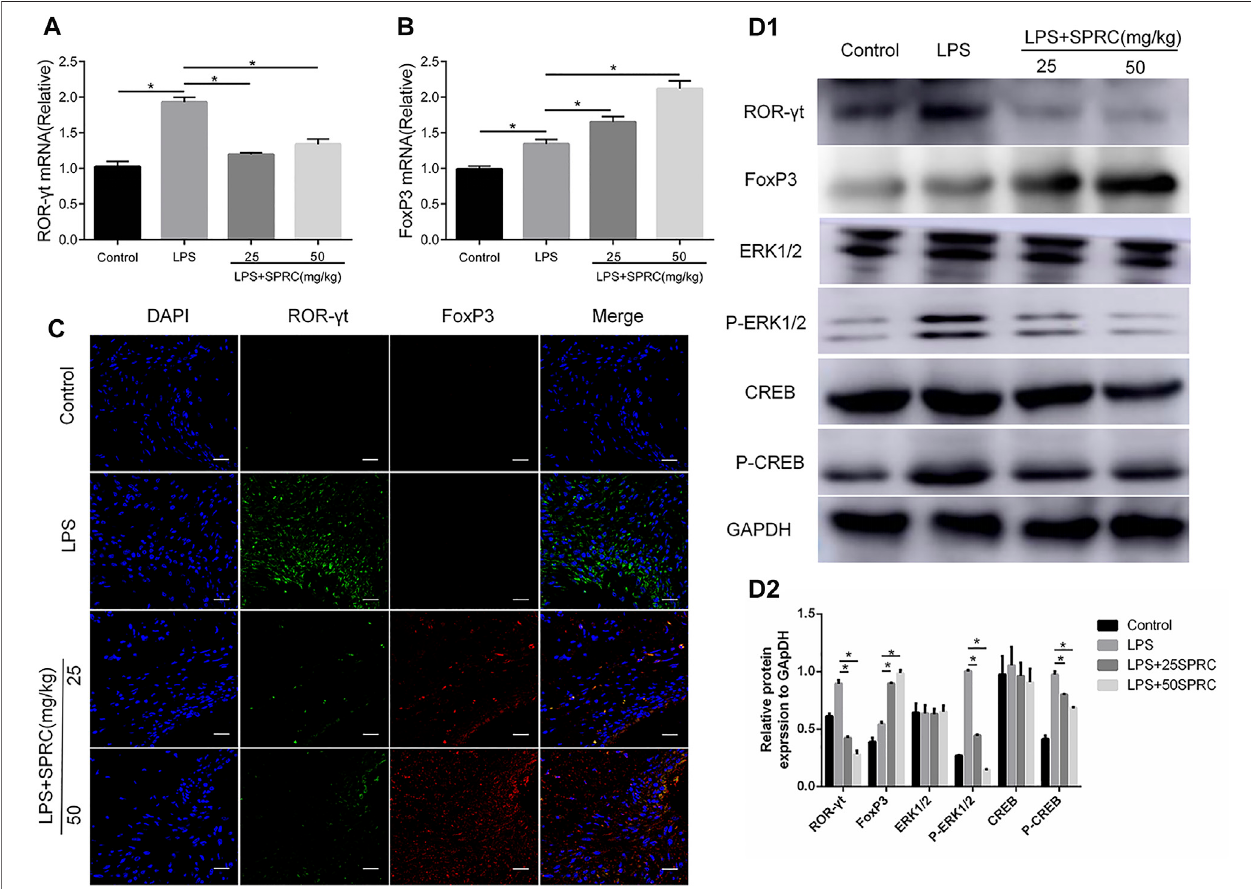
FIGURE 6 | Effect of SPRC on expression of ROR- γ t, FoxP3 and ERK1/2, CREB phosphorylation in gingival tissues, (A,B) Histogram expression of RT-PCR assaysforROR- γ tandFoxP3mRNAingingivaltissue, (C) Confocalmicroscopyresults.ROR- γ t(AlexaFluor488,green),FoxP3(AlexaFluor638,red)andDAPInuclear staining merged channels ( × 600 magni fi cation scale bar (cid:1) 20 μ m). (D1) Western blot assays for ROR- γ t, FoxP3,ERK1/2, CREB protein express and ERK1/2, CREB phosphorylation levels in gingival tissue. (D2) Quantitative analysis of western blot results. Data are shown as the means ± SD from 4 animals. *p < 0.05 vs. LPS